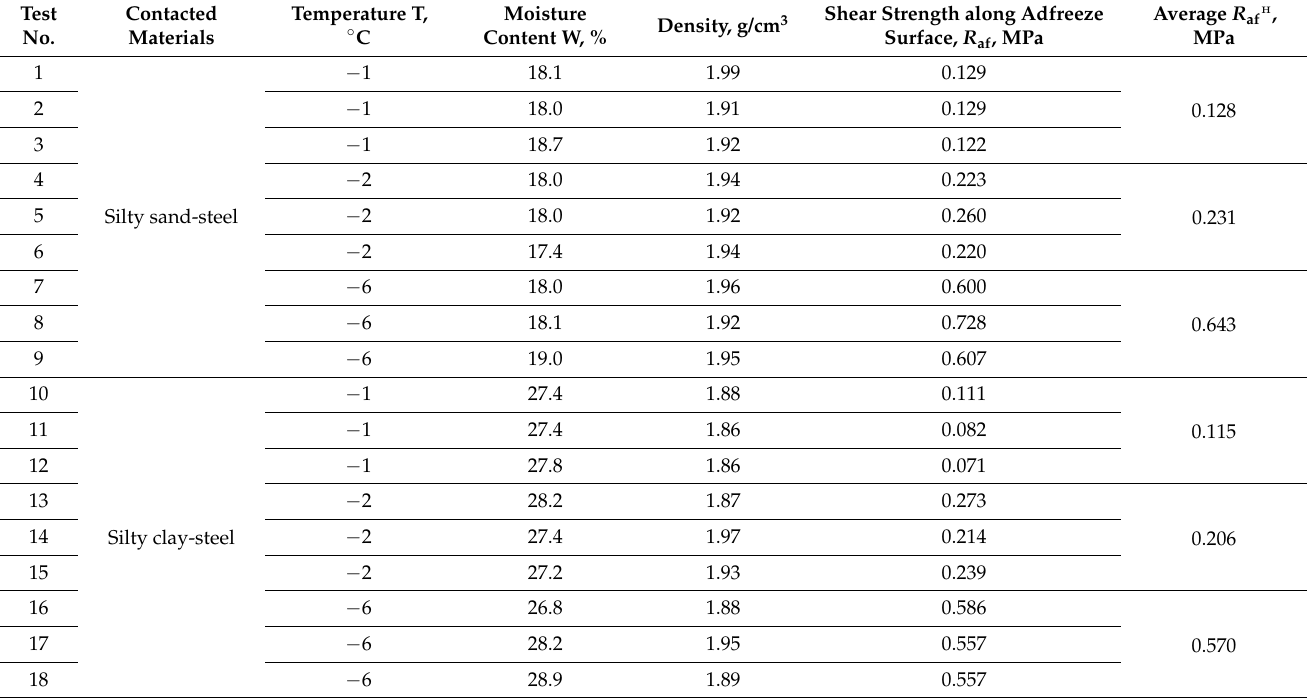
Table 3. Shear strength along soil-pile adfreeze surface, for uncovered piles and piles with the Reline jacket.